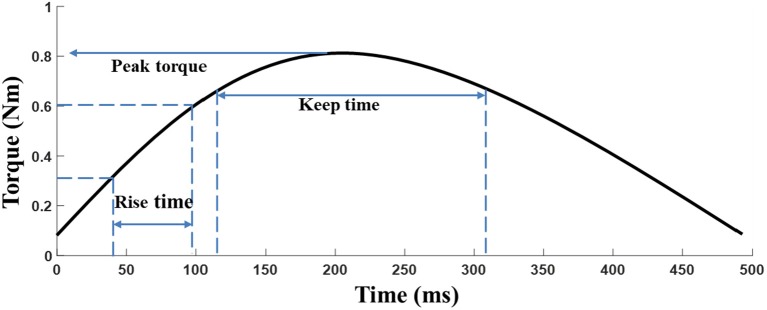
Description of the neuromechanical parameters for the MIVC.